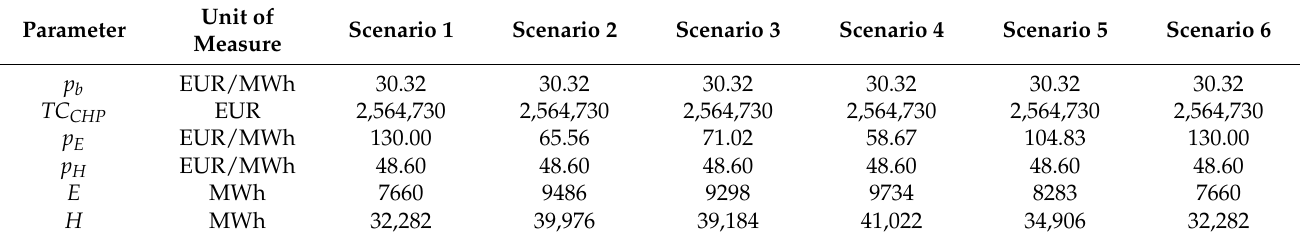
Table 5. Summary results for a 60% increase in the fuel